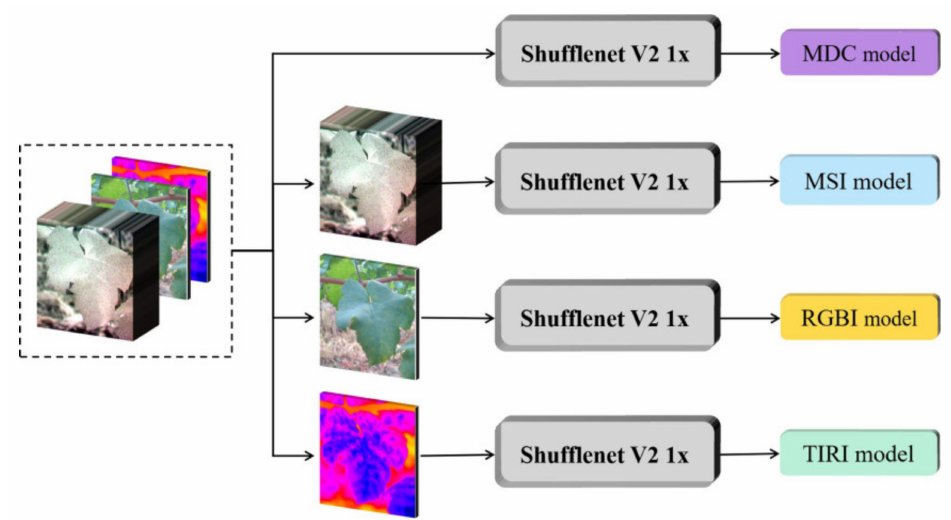
Figure 4. RGBI, MSI, TIRI, and MDC models for detection. The RGBI, MSI, and TIRI sets are obtained according to the corresponding channel ranges from the input MDC set. Based on the ShuffleNet V2 1x, MDC, MSI, RGBI, and TIRI models are trained on the relevant sets.